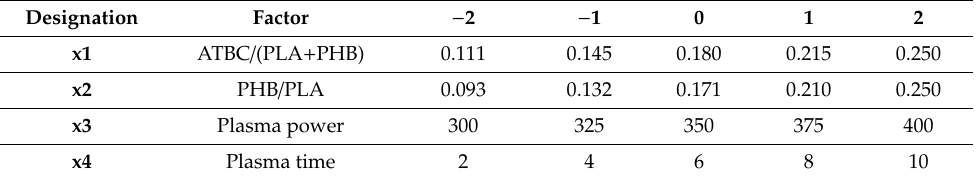
Table 1. Factors of design of experiment.